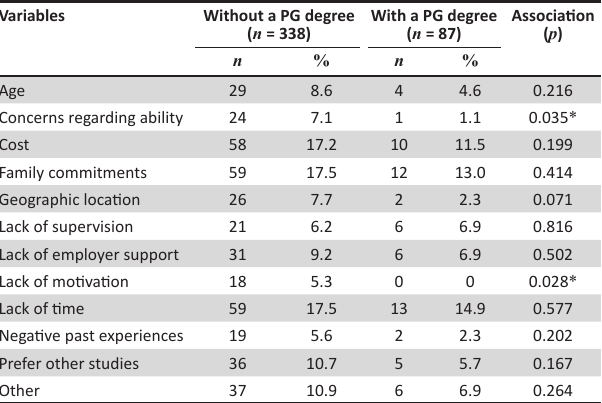
TABLE 2: Barriers to postgraduate study. TABLE 1: Sociodemographic data of study participants ( n = 425).